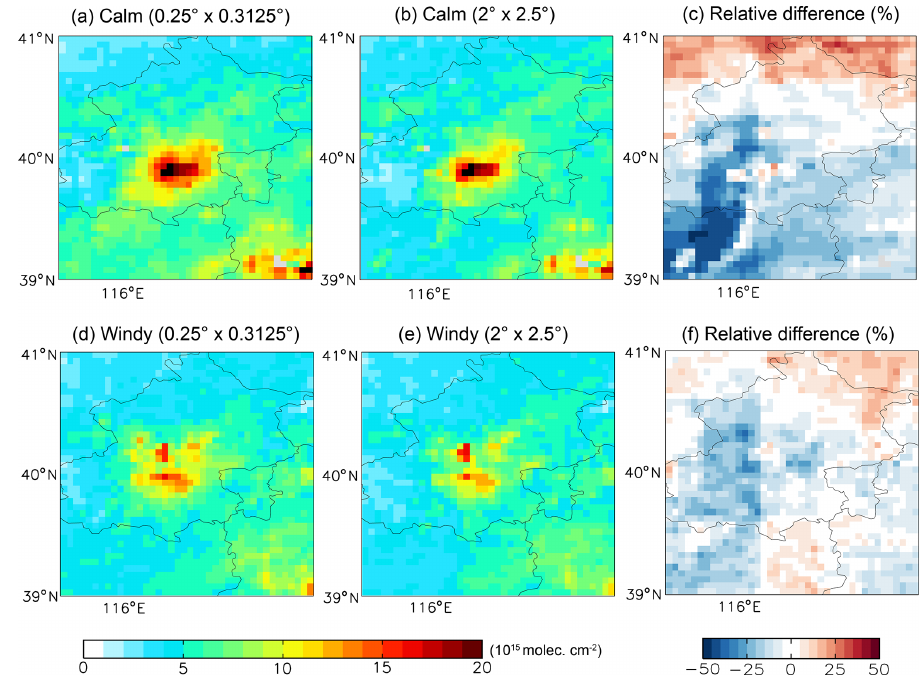
Figure 8. Spatial distributions of POMINO-TROPOMI NO 2 VCDs on a 0 . 05 ◦ × 0 . 05 ◦ grid under calm conditions with (a) 0.25 ◦ lat × 0.3125 ◦ long NO 2 profiles (Case 1), with (b) 2 ◦ lat × 2.5 ◦ long profiles (Case 2), and (c) their relative differences. Panels (d) – (f) are similar to panels (a) – (c) but under windy conditions.